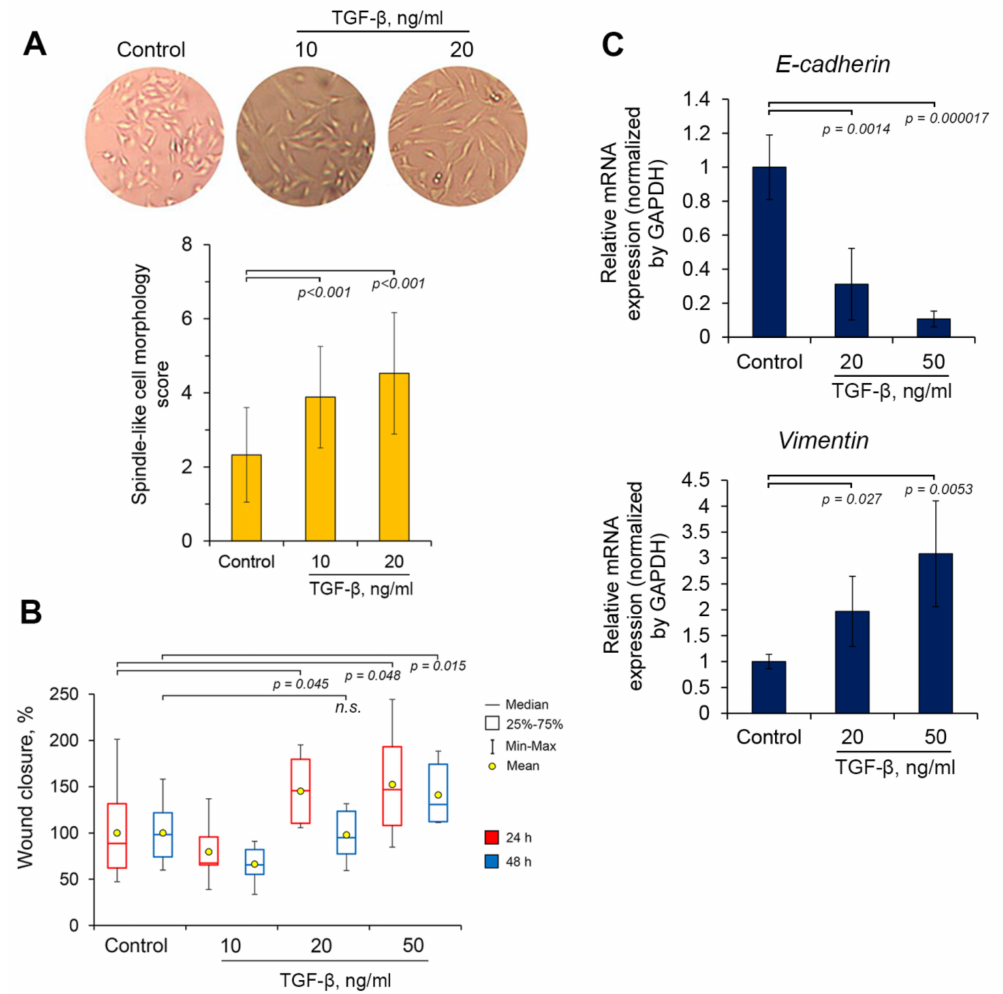
Figure 4. Selection of working concentration of transforming growth factor β (TGF- β ) for induction of EMT of tumor cells. ( A ) TGF- β led to an acquisition of spindle-like phenotype by tumor cells. A549 cells were treated with TGF- β for 48 h followed by the evaluation of cellular morphology using phase contrast microscopy and the measurement of long and short axes of 200 random cells using ImageJ tool. ( B ) TGF- β increased motility of tumor cells. Scratched monolayers of A549 cells were treated with TGF- β for 24 h and 48 h after that wound closure rate was calculated using ImageJ software. ( C ) TGF- β switched expression of EMT-associated molecular markers to mesenchymal ones. Results of RT-PCR were from two independent experiments performed in tetraplicate. Relative expression levels were shown as mean ± standard deviation. Glyceraldehyde-3-phosphate dehydrogenase (GAPDH) was used as a housekeeping gene for